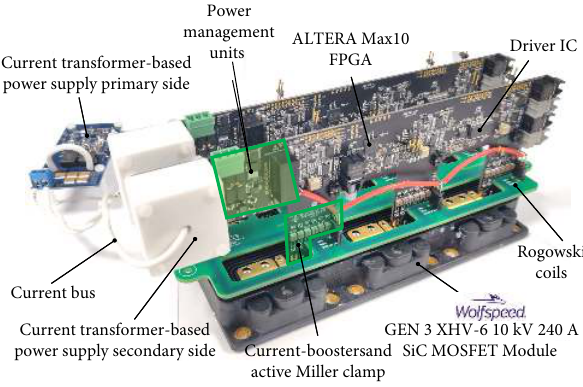
Fig. 3 Two eGD boards with CT-based PS assembled with a Rogowski coil board on an XHV-6 SiC MOSFET.